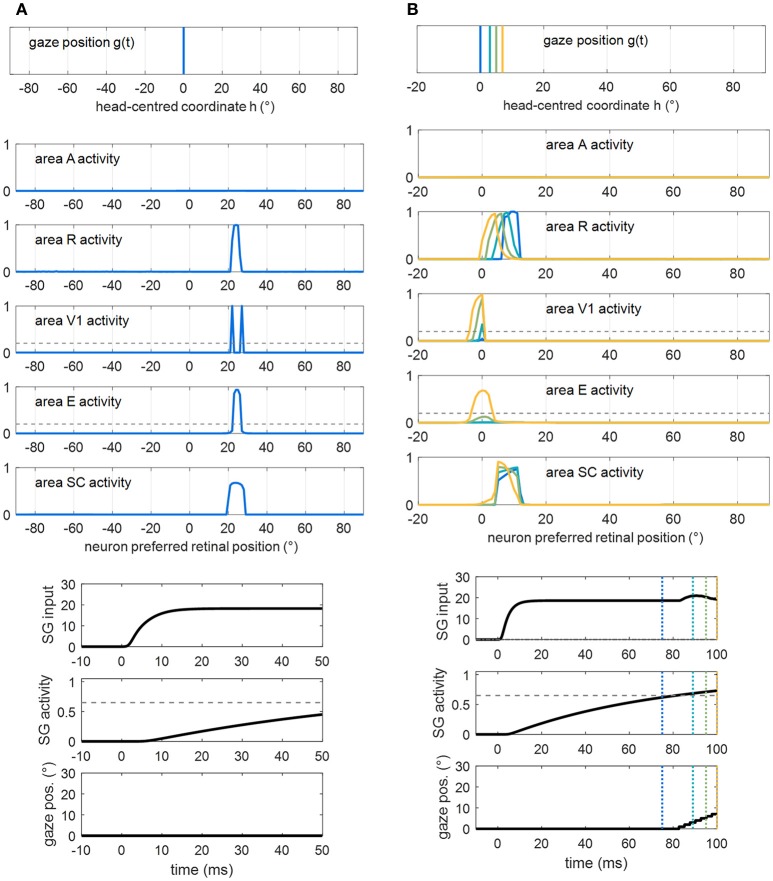
Examples of successful visual detection after training A. (A) The unisensory visual stimulus is applied in a position where the restitutive R-SC-E circuit was trained (p = 24° in patient #9). Shortly after stimulus presentation, detection occurs (both V1 and E activation overcomes the detection threshold, dashed gray line), before the oculomotor response is triggered. Compare this figure with Figure 5B (dotted purple lines). (B) The visual stimulus is applied in a position where the compensatory R-SC-SG circuit was trained (p = 8° in patient #1), close to the intact V1 side. The oculomotor response is triggered at t = 82 ms and the stimulus is detected at t = 96 ms while approaching 0°.